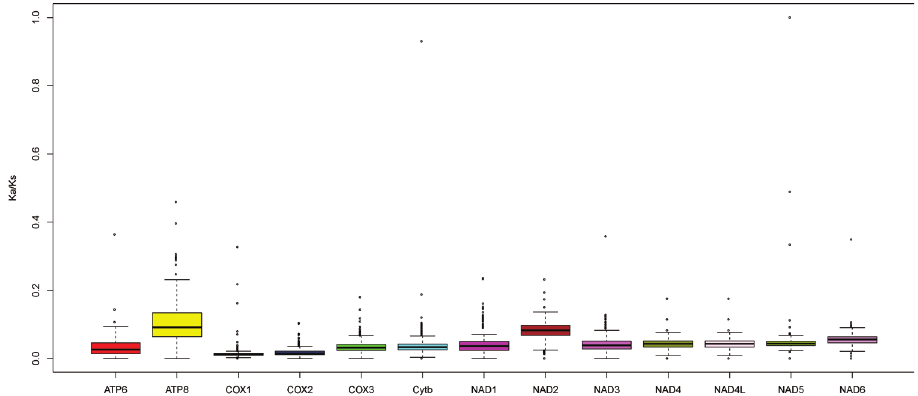
Figure 3. Ka/Ks of each PCG from 33 bagrid catfishes mitogenomes ( Rita rita was excluded).